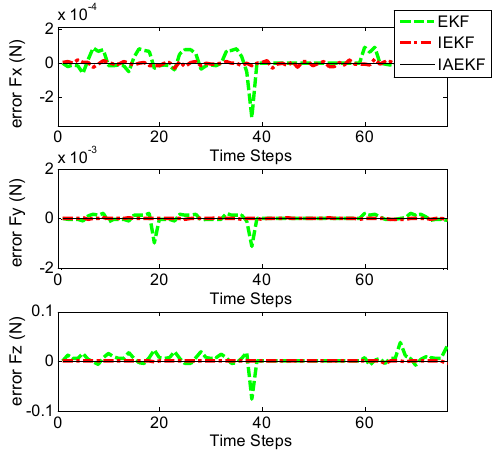
Figure 3. Ground truth of contact force applied to the catheter tip.